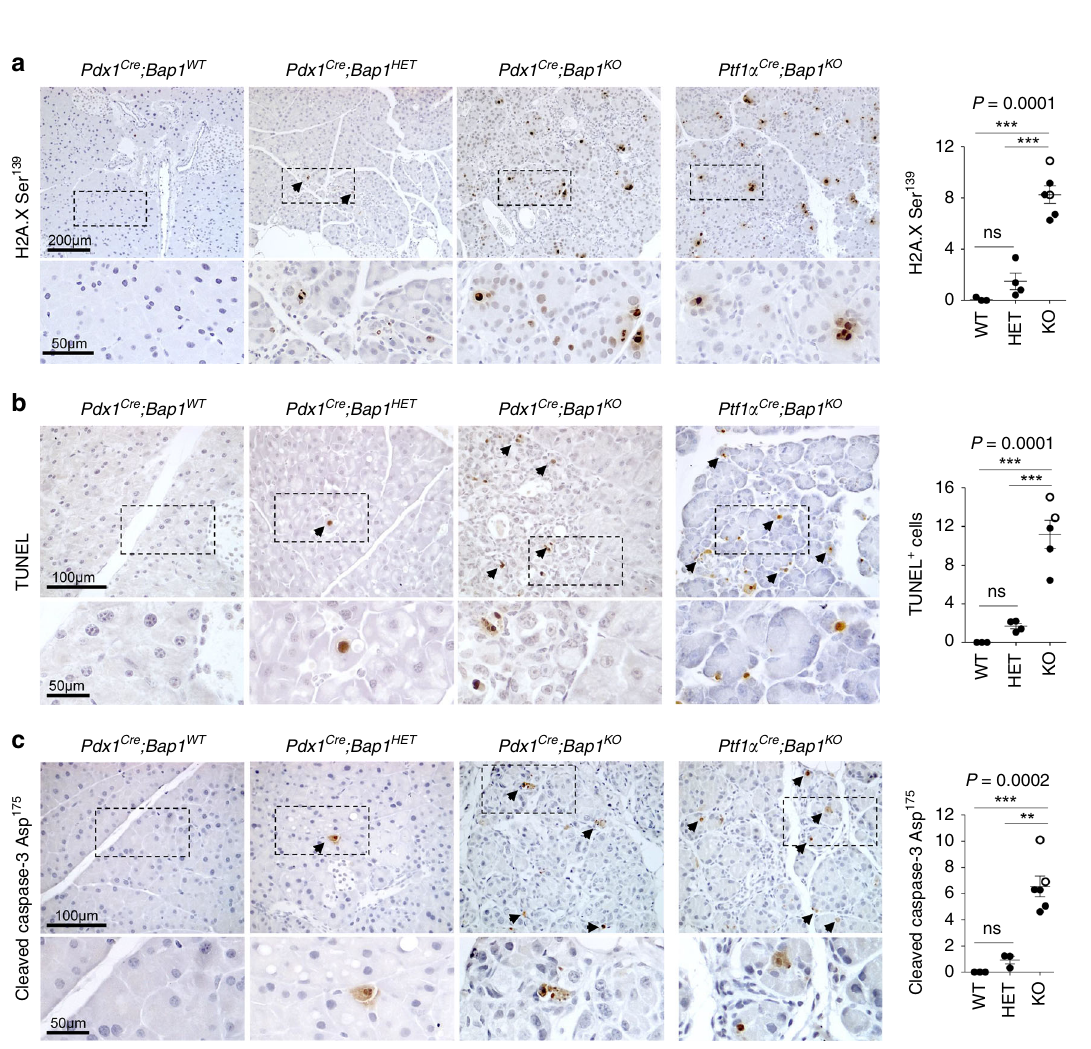
Fig. 3 BAP1 loss triggers a DNA damage response. a H2A.X phosphorylated at Ser139 (WT n = 3, HET n = 4, KO n = 6 mice), b TUNEL (WT n = 3, HET n = 4, KO n = 5 mice), and c cleaved Caspase-3 IHC (WT n = 3, HET n = 3, KO n = 6 mice) in 8 – 10-week-old mice of the indicated genotypes. Arrows indicate positively stained cells. Right: scatter dot plots showing the number of positive cells (mean ± SEM) per 0.1 mm 2 of tissue per mouse. Each dot represents a mouse. Filled and open circles indicate mice from the Pdx1 Cre and Ptf1 α Cre cohorts, respectively. Mice lacking the Cre allele were used as control for both cohorts. Statistical signi fi cance was determined by one-way ANOVA with p -values shown on the top of each plot, followed by Tukey ’ s multiple comparison post-hoc test between groups. ns, nonsigni fi cant; ** p < 0.01; *** p < 0.001. Source data are provided as a Source Data fi